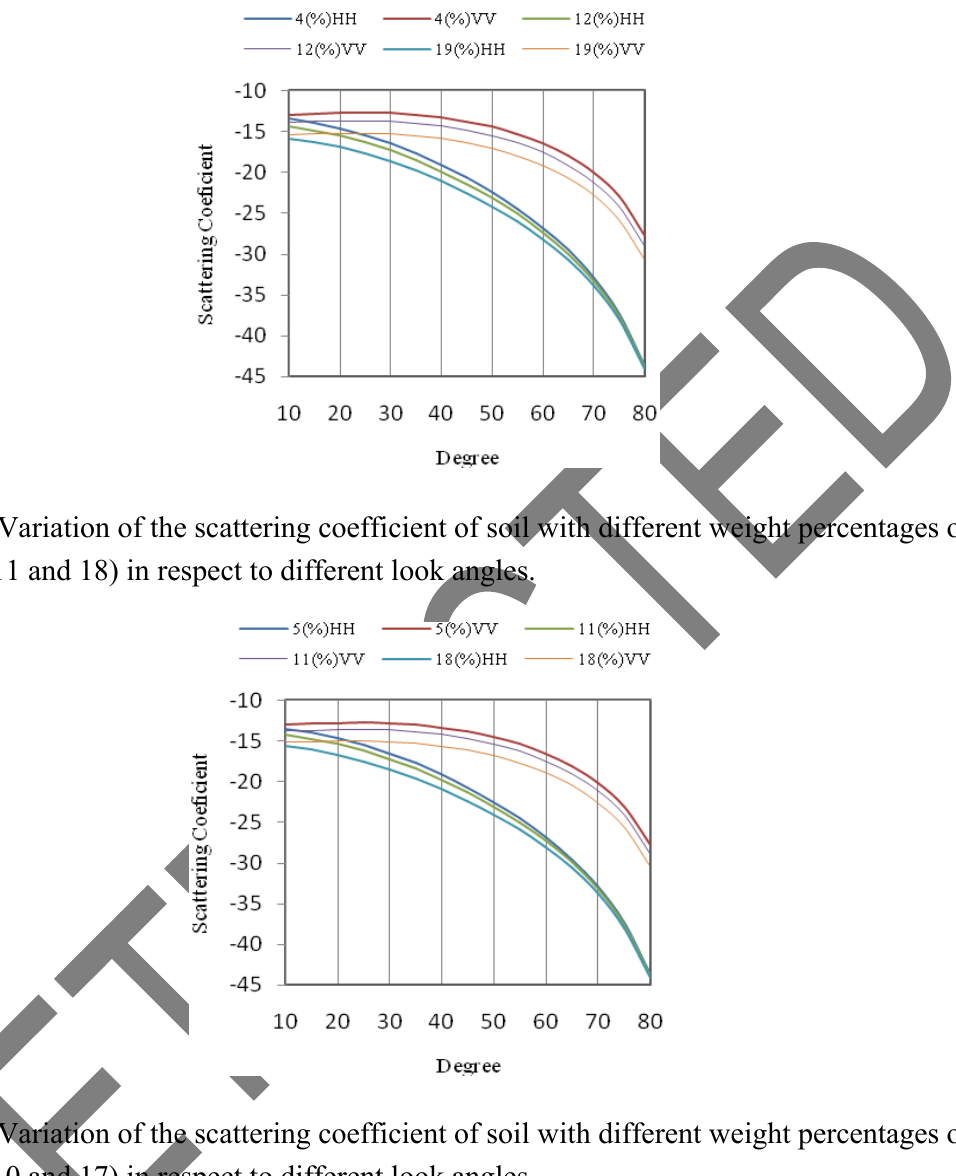
Figure 5. Variation of the scattering coefficient of soil with different weight percentages of diesel (4, 12 and 19) in respect to different look angles.